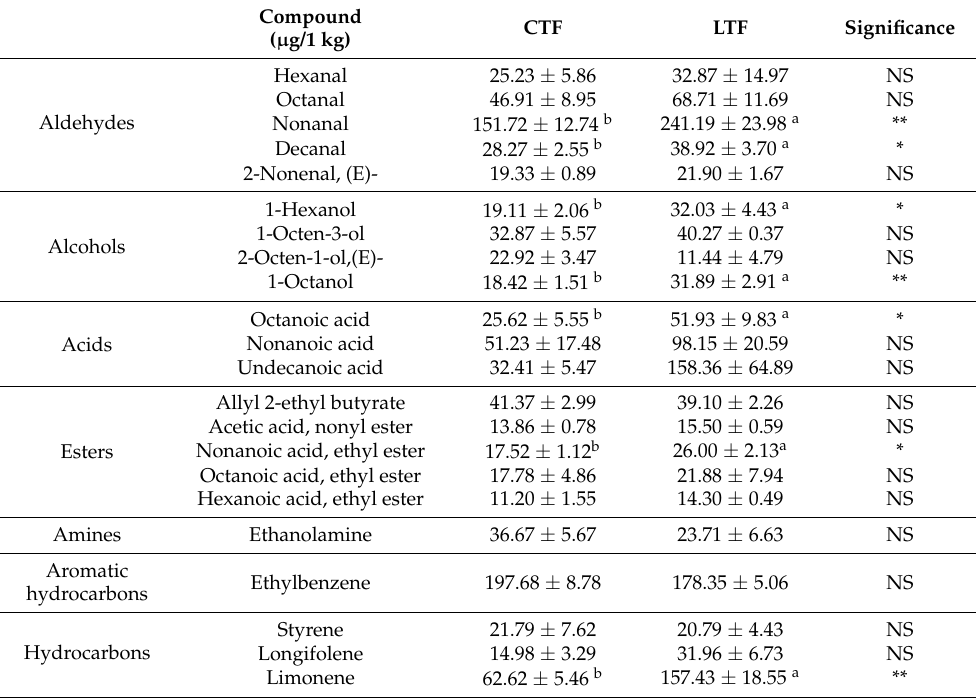
Table 2. Volatile compounds of Sunit sheep crude tail fat ( µ